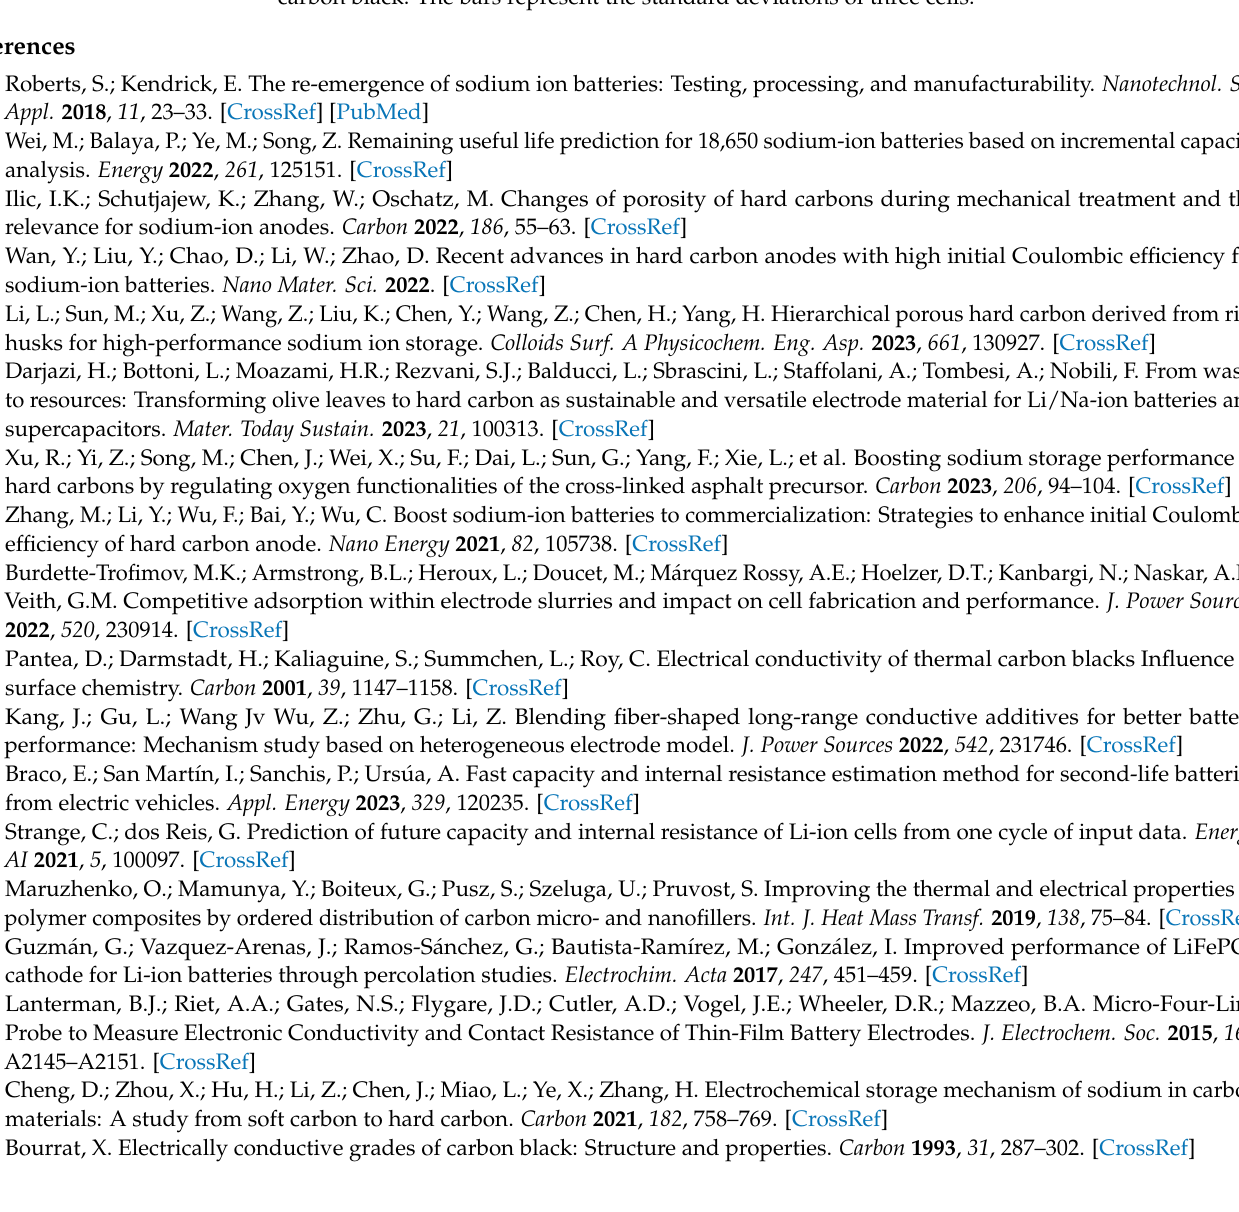
Figure A8. Coulombic efficiency of the half-cells made with Kuranode hard carbon containing 2% carbon black. The bars represent the standard deviations of three cells.